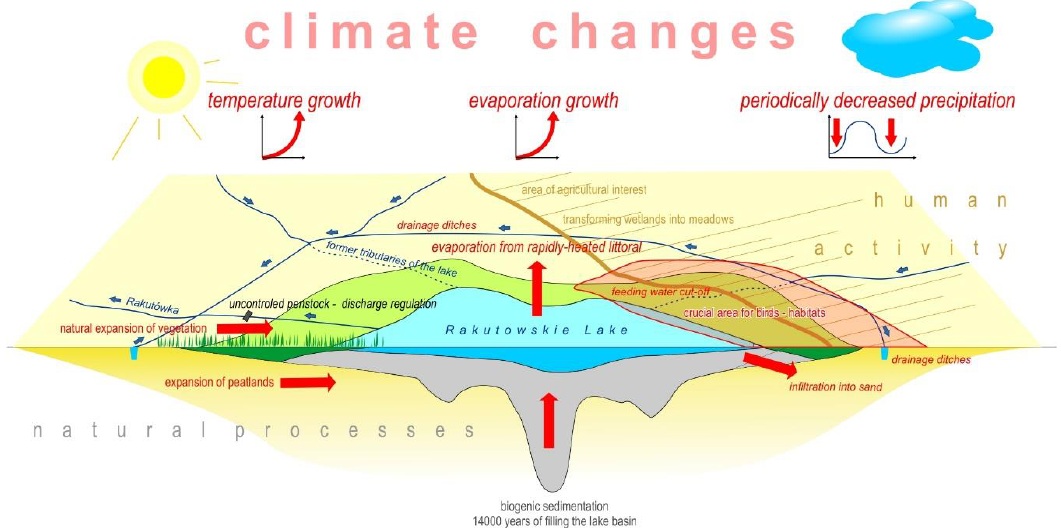
Figure 8. Schematic model of ecological changes of the Rakutowskie Lake ecosystem.